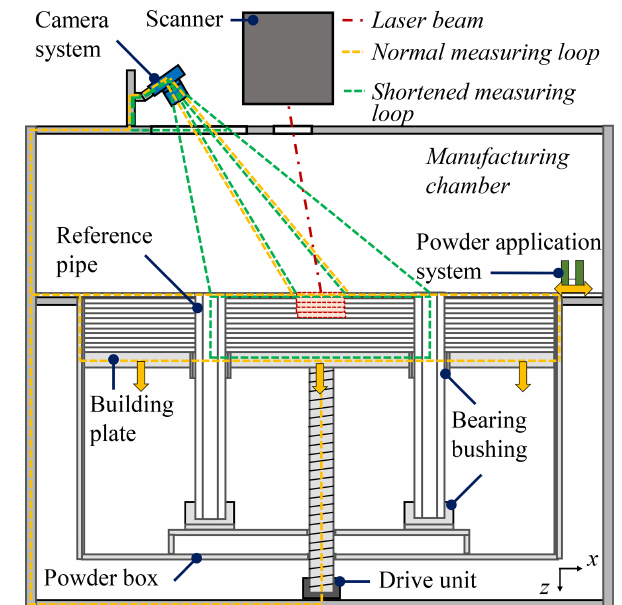
Figure 3. Principle of shortening of measuring loop by reference pipes integrated in the building plate (orange conventional long measuring loop, green shortened measuring loop) (according to Hausotte,